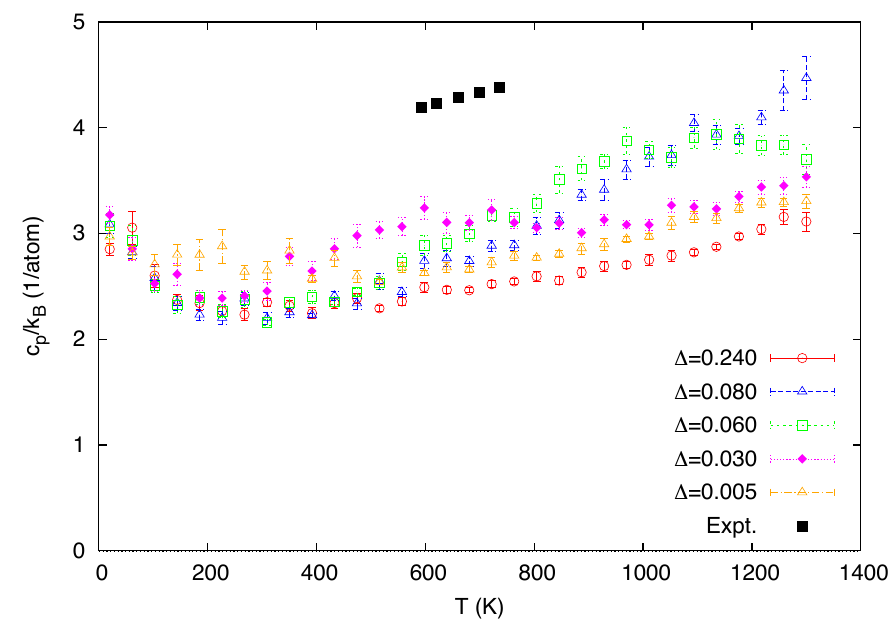
Figure 3. Calculated temperature dependence of the heat capacity per atom, scaled with the Boltzmann constant, for a varying value of the mixing energy ∆ (in eV). The experimental data [48] in the stability range of δ -Pu are also included for